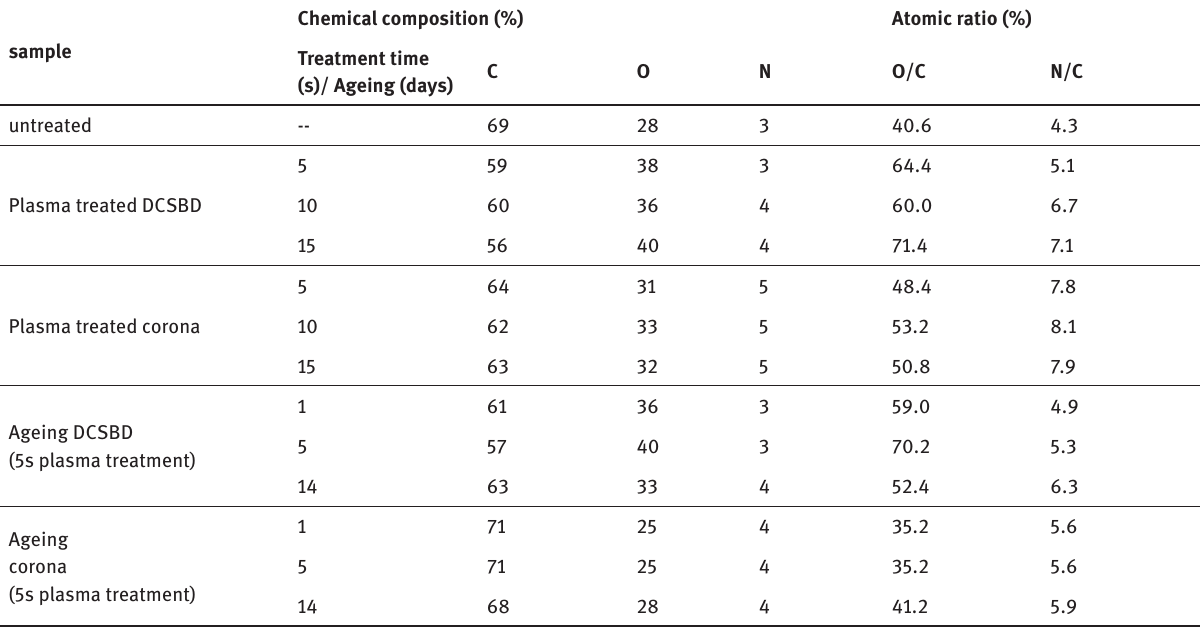
Table 1 : XPS elemental analysis of the untreated and plasma treated PA-12 foils.